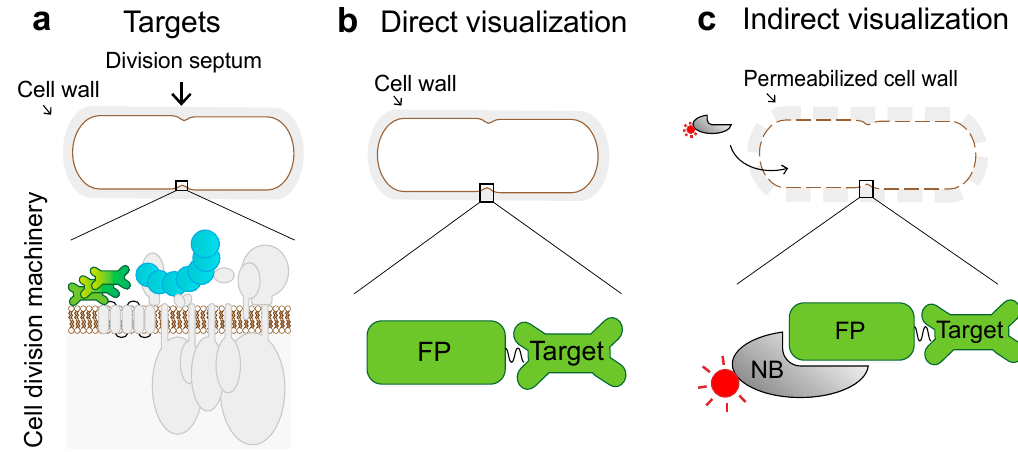
Figure 1. Schematic diagram of the bacterial protein complex and methods for visualization. ( a ) Cartoon representation of the B. subtilis cell featuring cell wall (gray), cell membrane (brown), and cell division proteins forming the cell division machinery. Proteins FtsZ and DivIVA visualized in this study are highlighted in blue and green, respectively. ( b ) The signal from a fluorescent protein (FP) fused to the target protein is directly visualized or ( c ) the target is indirectly visualized by fluorescently (red) labeled nanobodies (NB).